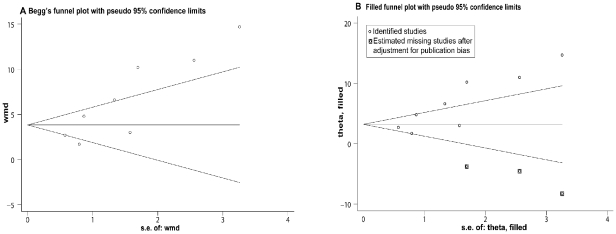
Funnel plot of all studies on the effects of PTH and bisphosphonates on spine BMD.A: Begg's funnel plot with pseudo 95% confidence limits. B: Filled funnel plot with pseudo 95% confidence limits. WMD, weighted mean difference; S.E., standard error.